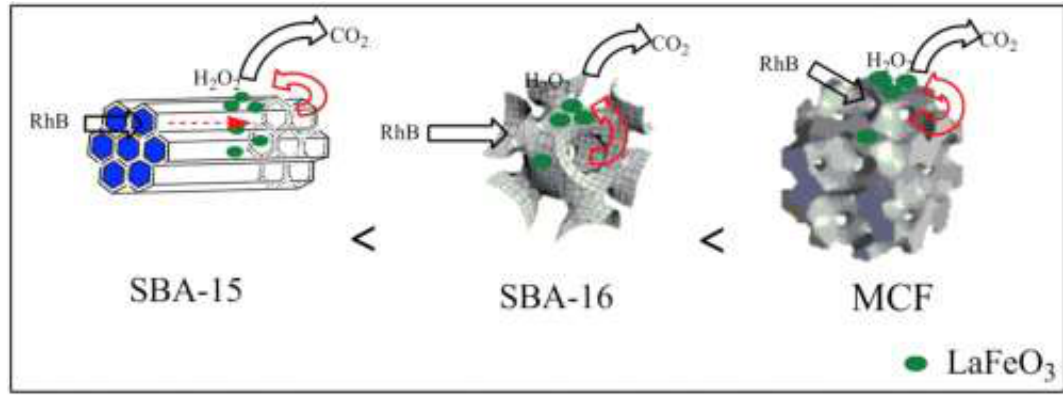
Figure 2. A proposed scheme of transporting RhB from the solution to the pore and then to the surface-active site over LaFeO 3 catalysts supported on porous SBA-15, SBA-16 and MCF. With permission from